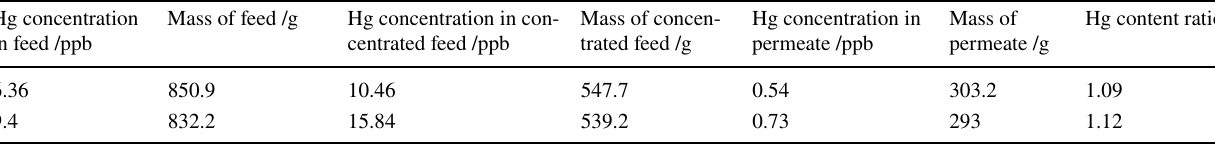
Fig. 9 Antifouling performance of c-GO-PEI membrane in treating with Hg-containing wastewaters. (a) Flux; (b) Salt rejection and removal rates of NPOC and Hg (Operating temperature: 65 °C)